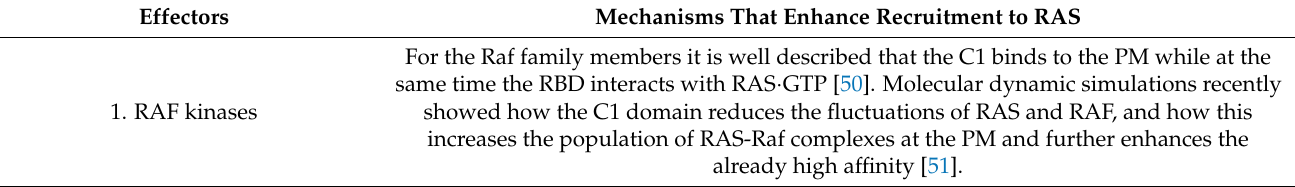
Table 1. RAS binding mechanisms of RAS effector